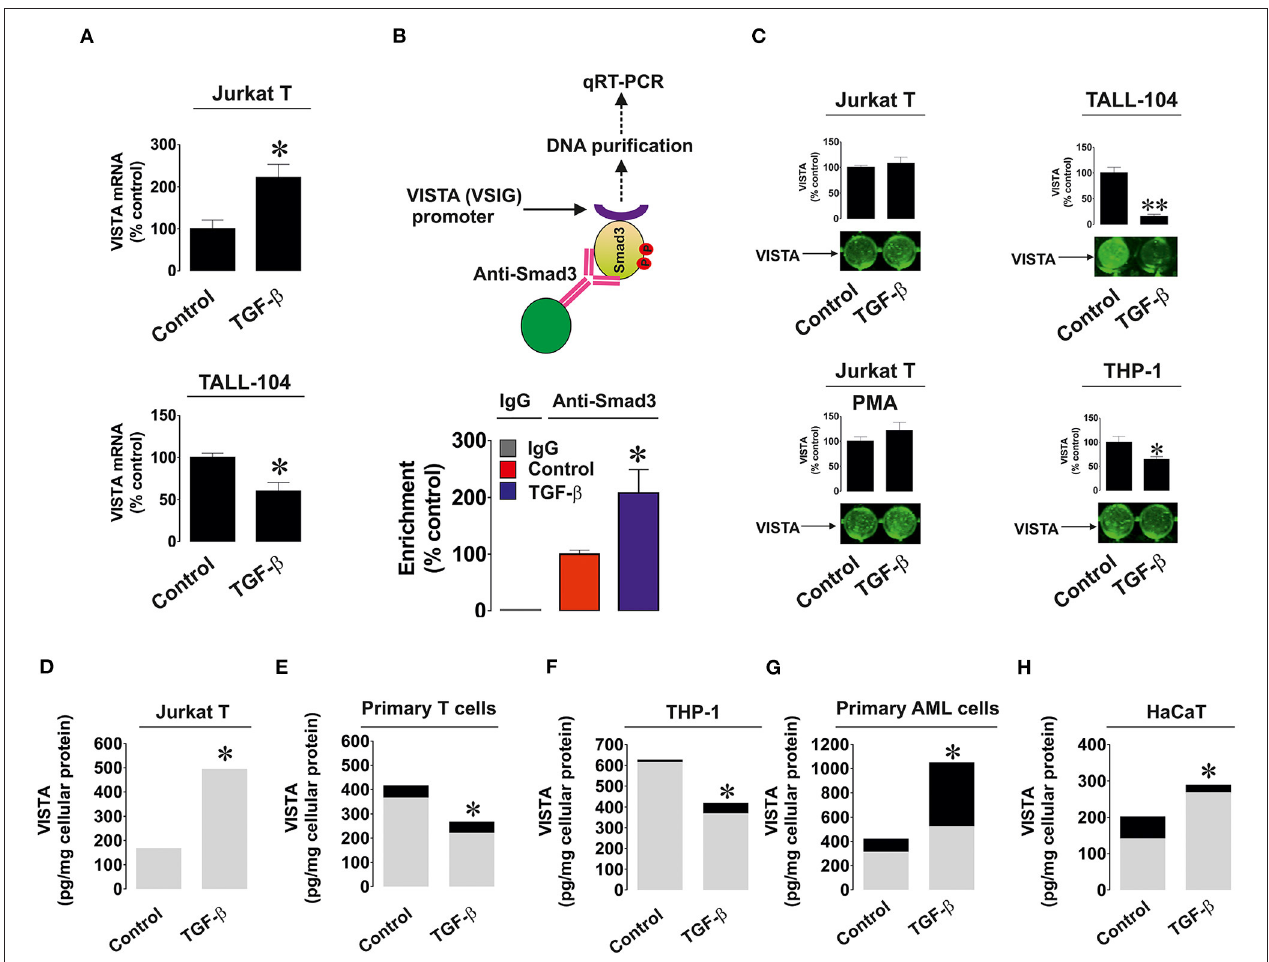
FIGURE 2 | Effects of TGF- β on expression and distribution of VISTA in various human cell types. (A) Jurkat T and TALL-104 cells were exposed to 2ng/ml TGF- β for 24h followed by total RNA isolation and detection of VISTA mRNA using qRT-PCR as outlined in Materials and Methods; (B) Resting Jurkat T cells and those treated for 24h with 2ng/ml TGF- β were subjected to ChIP followed by qRT-PCR as described in Methodology section in order to detect whether Smad3 binds to the VSIG promoter region; (C) Resting as well as PMA-activated Jurkat T cells, TALL-104 and THP-1 cells were exposed for 24h to 2ng/ml TGF- β followed by detection of cell surface-based VISTA by on-cell Western (see Materials and Methods for details); Jurkat T cells (D) , primary human T lymphocytes (E) , THP-1 AML cells (F) , primary AML blasts (G) and HaCaT keratinocytes (H) were exposed to 2ng/ml TGF- β for 24h followed by detection of cell-associated (gray color) and secreted (black color) VISTA levels. Images are from one experiment representative of 5 which gave similar results. Data are the mean values of 5 independent experiments. * p < 0.05 vs. control (total